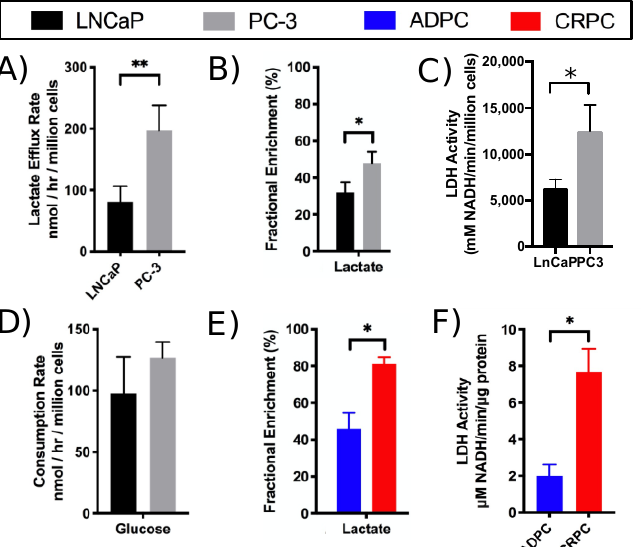
five-digit number in Figure 3C , for example: 10,000. Please